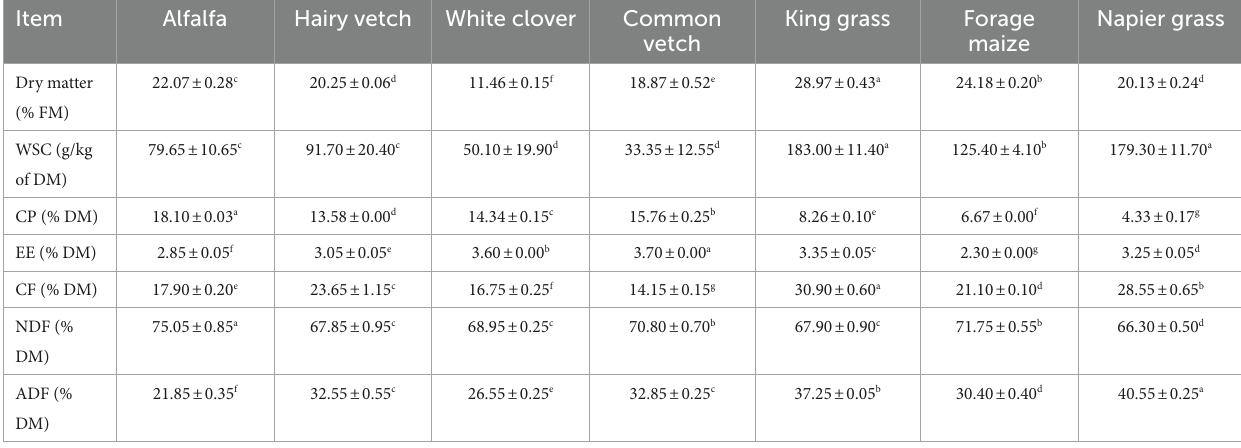
TABLE 1 Chemical composition in fresh raw materials.